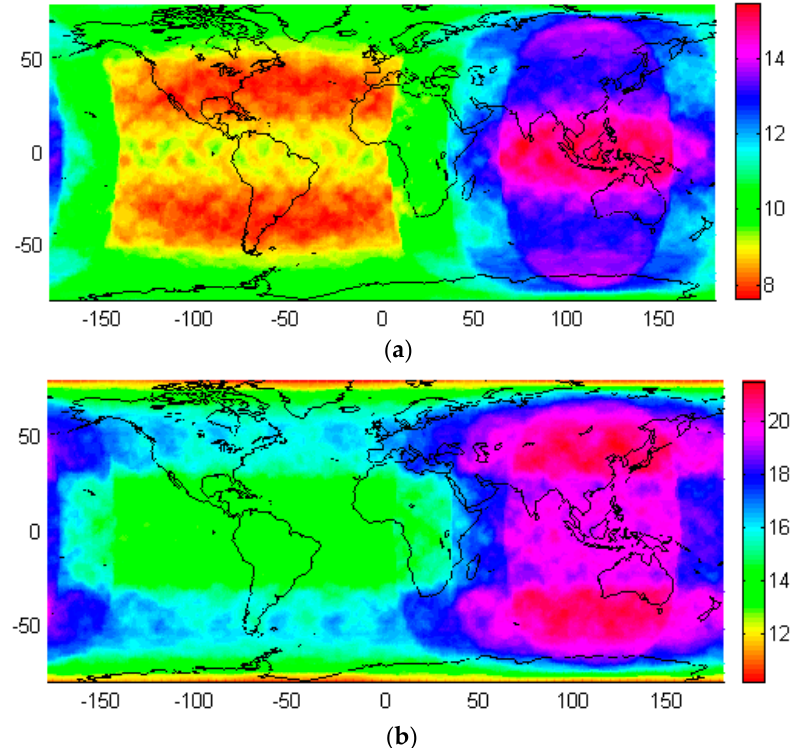
Figure 3. Global distribution for satellite visibility of BeiDou-3-only ( a ) and BeiDou-3/LEO combined constellation ( b ).